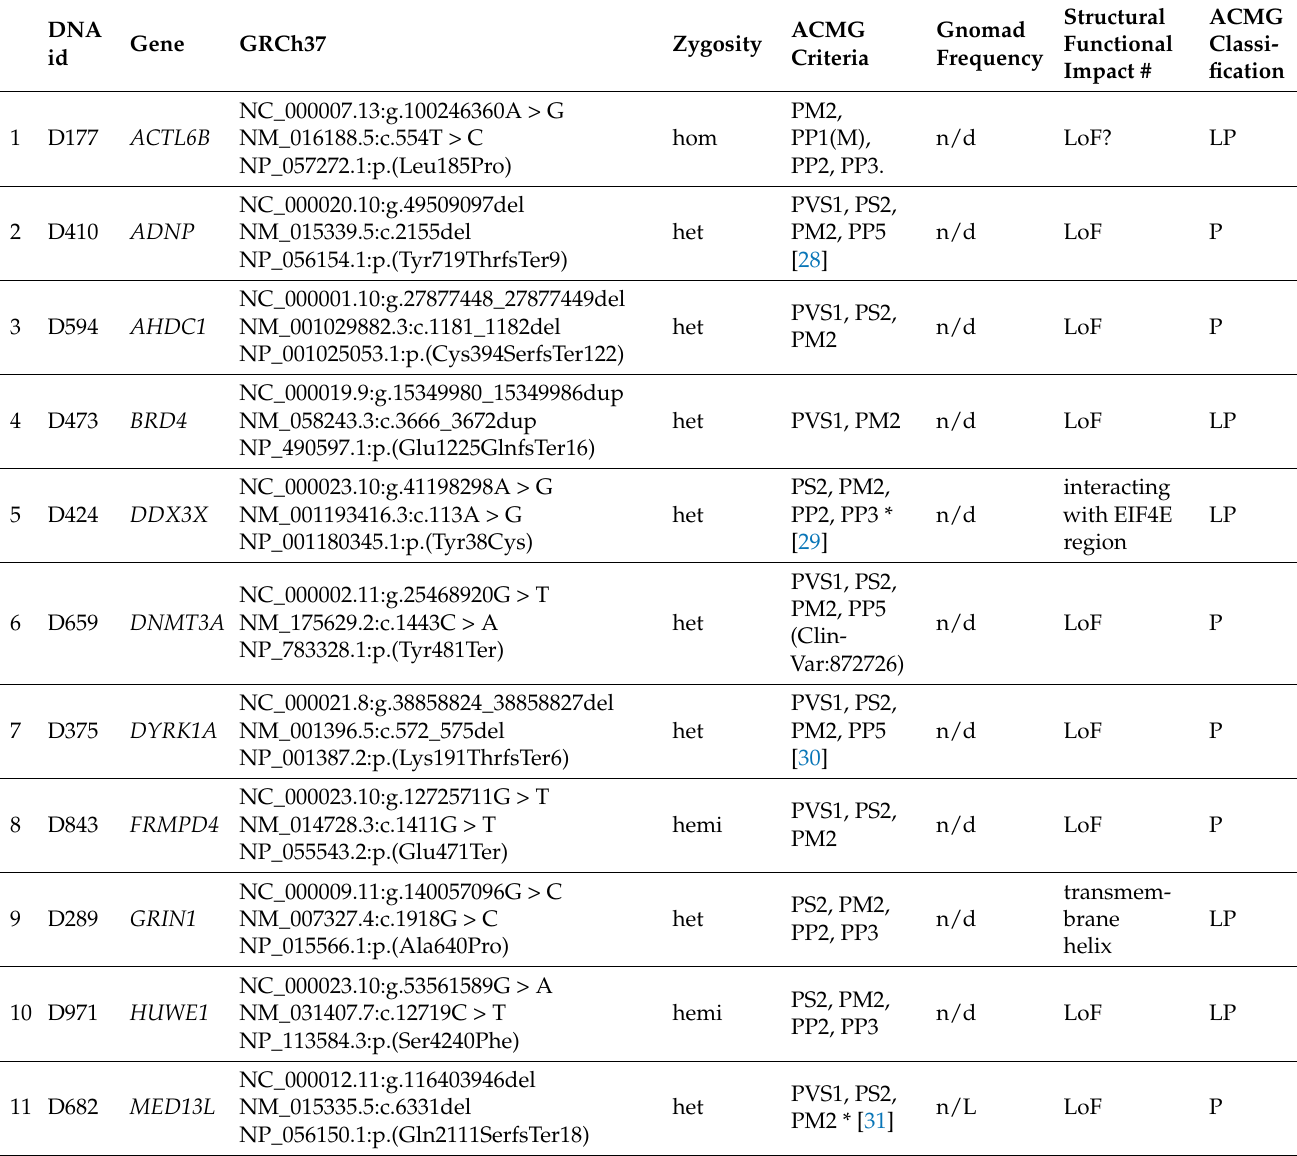
Table 2. Variants classified as pathogenic or likely pathogenic by ACMG